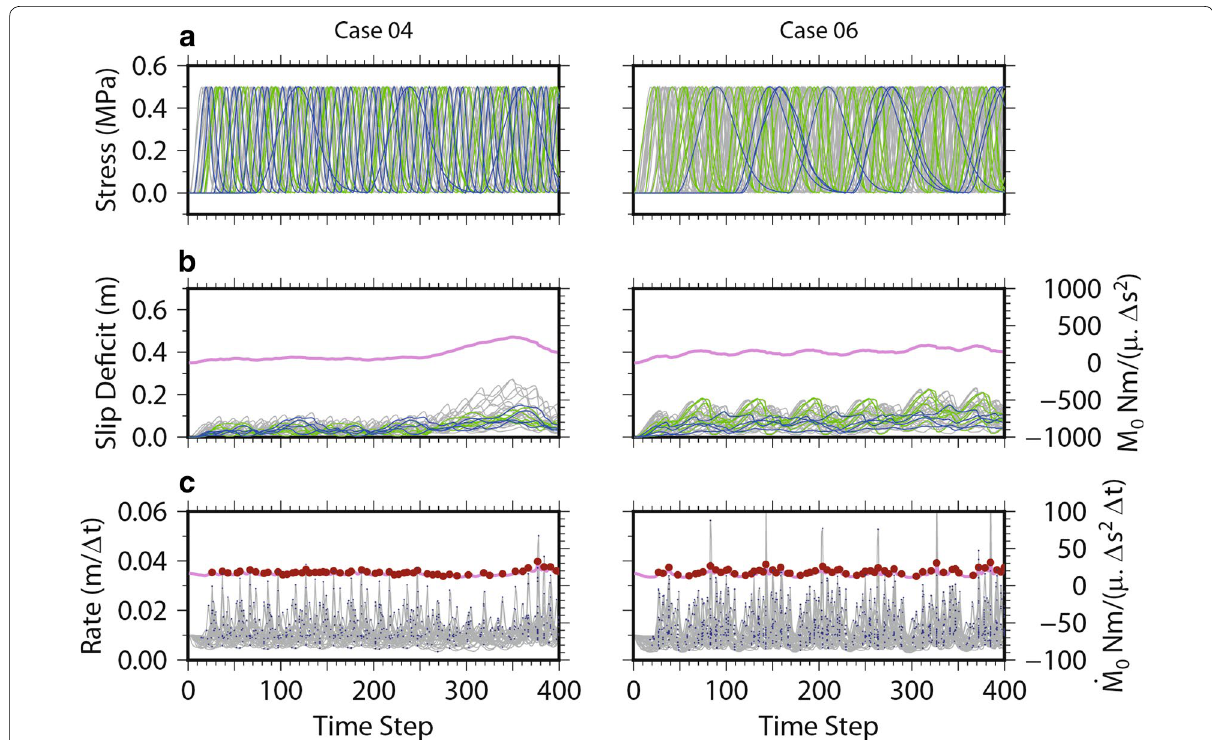
Fig. 7 Simulated temporal evolution for cases (4) and (6), whose patch distributions are shown in Fig. 6. a Shear stress evolution at the center of each patch. The colors correspond to the order of the patches, with blue , green , and gray used for k = 2,3,and 4 , respectively. b Average slip deficit across each patch. M 0 is shown by a pink curve. c Average slip rate across each patch. ˙ M 0 is shown with a pink curve . The local peaks in slip rate are identified by blue dots , whereas the red circles correspond to the peaks in ˙ M 0 for each time step